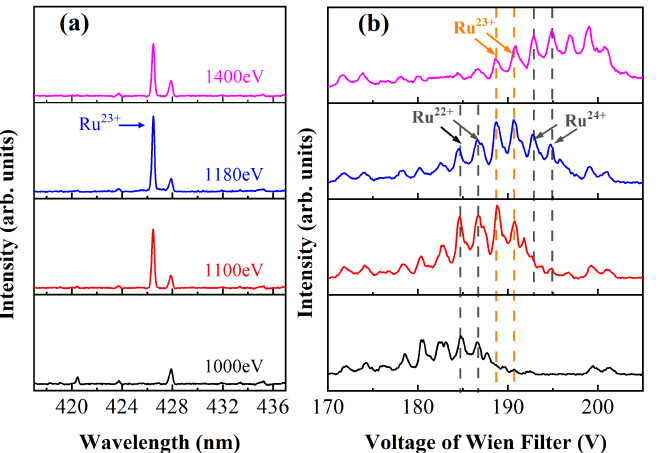
Figure 1. ( a ) Electron beam energy dependence of a transition belonging to Ru 23 + , ( b ) the corre- sponding charge state distributions of ruthenium ions. The relationship between the Wien Filter voltage and the ion charge state was calibrated using argon ions in a pre-experiment. The positions of Ru 22 + –Ru 24 + are marked with dashed lines. Two separate peaks are resulted from superposition of peaks of different Ru